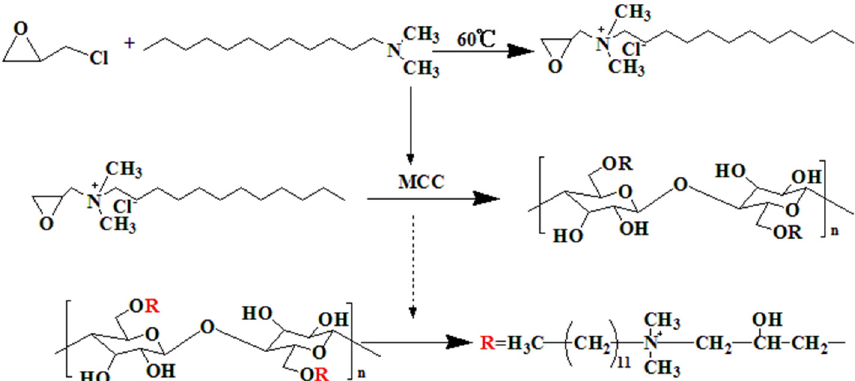
Figure 1. Preparation of quaternary ammonium salt–modified cellulose (QMCC) via grafting quaternary ammonium salt (QAS) on cellulose.